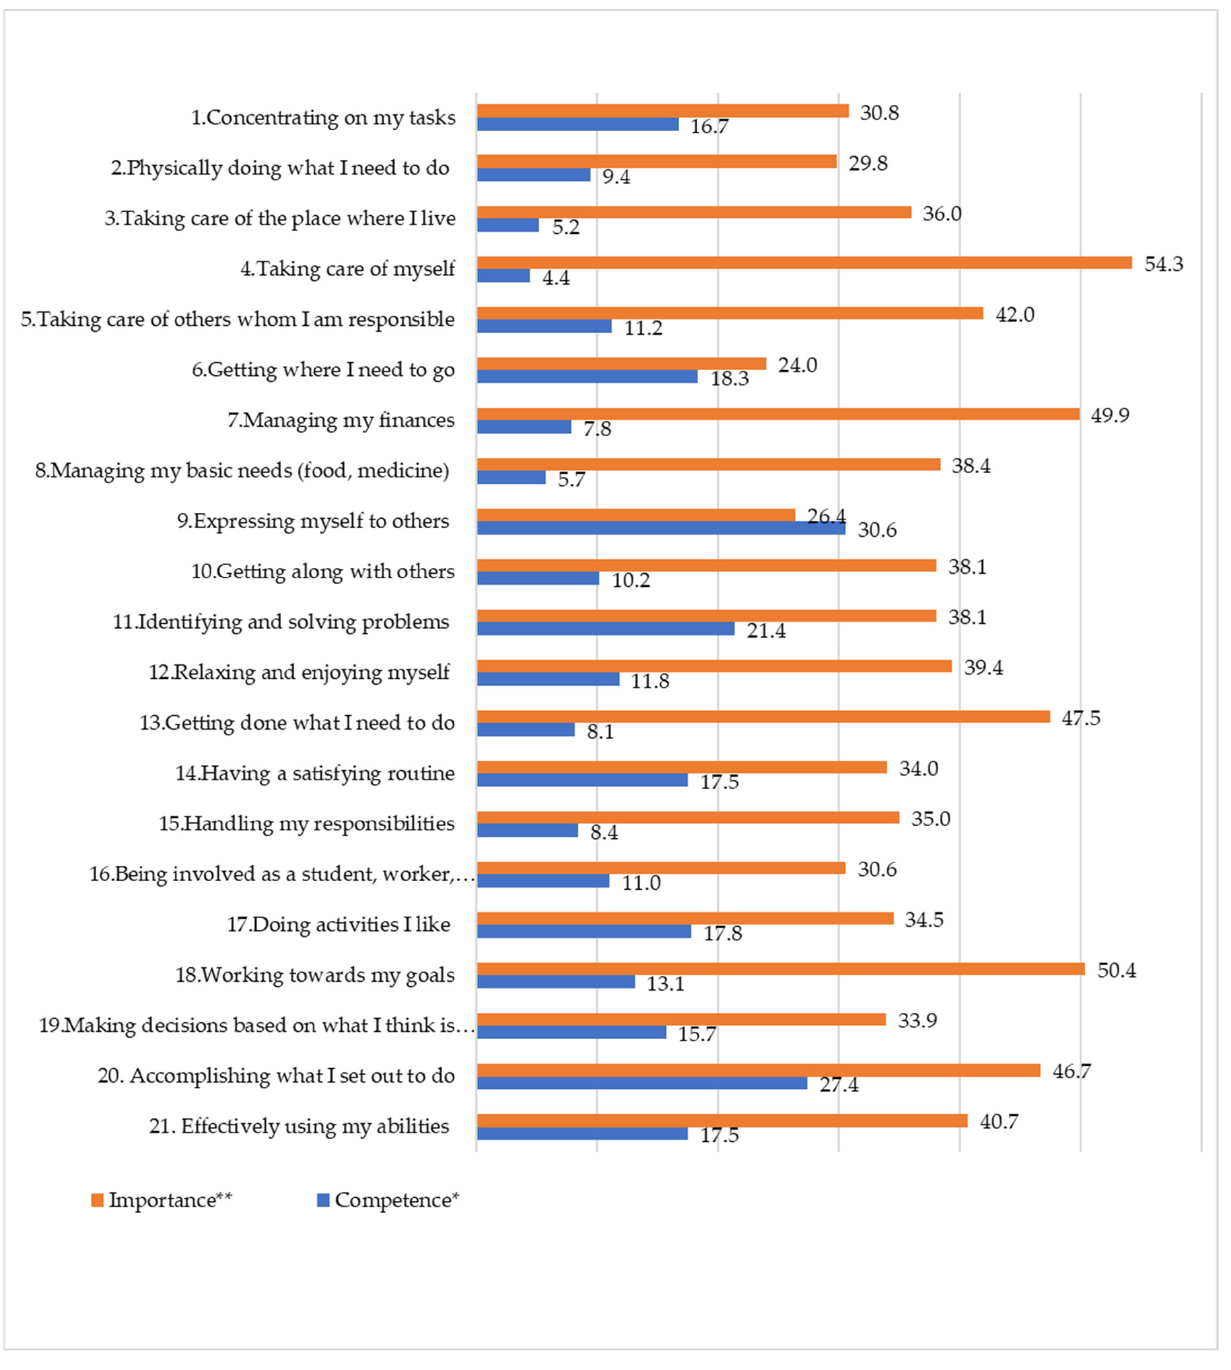
Figure 2. Proportions of competence and importance of occupation items. * A proportion of trainees who answered “I have a lot of problems doing this” or “I have some difficulty doing this” in a 4-point Likert scale question. ** A proportion of trainee who answered “this is more important to me” or “this is most important to me” in a 4-point Likert scale